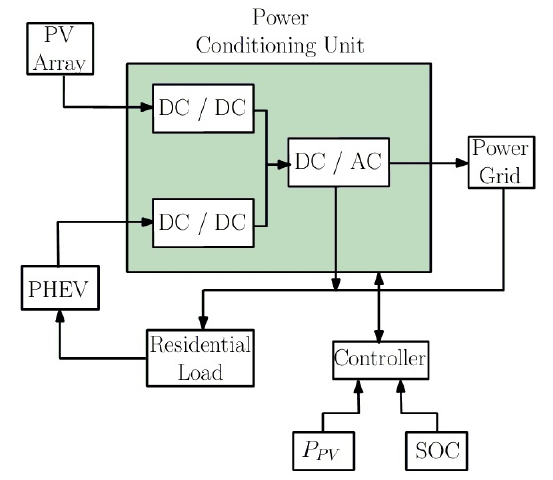
Figure 1. Basic block diagram with directions of power flow